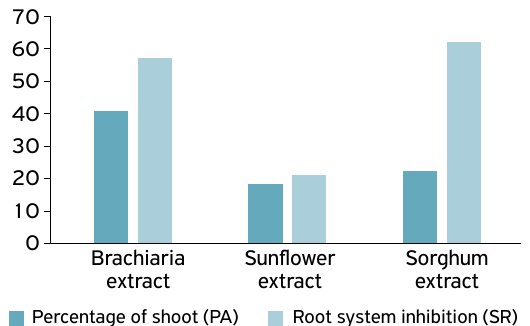
Figure 1. Percentage of shoot and root system inhibition of Bidens pilosa L. submitted to treatments with allelopathic extract, Cruz das Almas, BA,